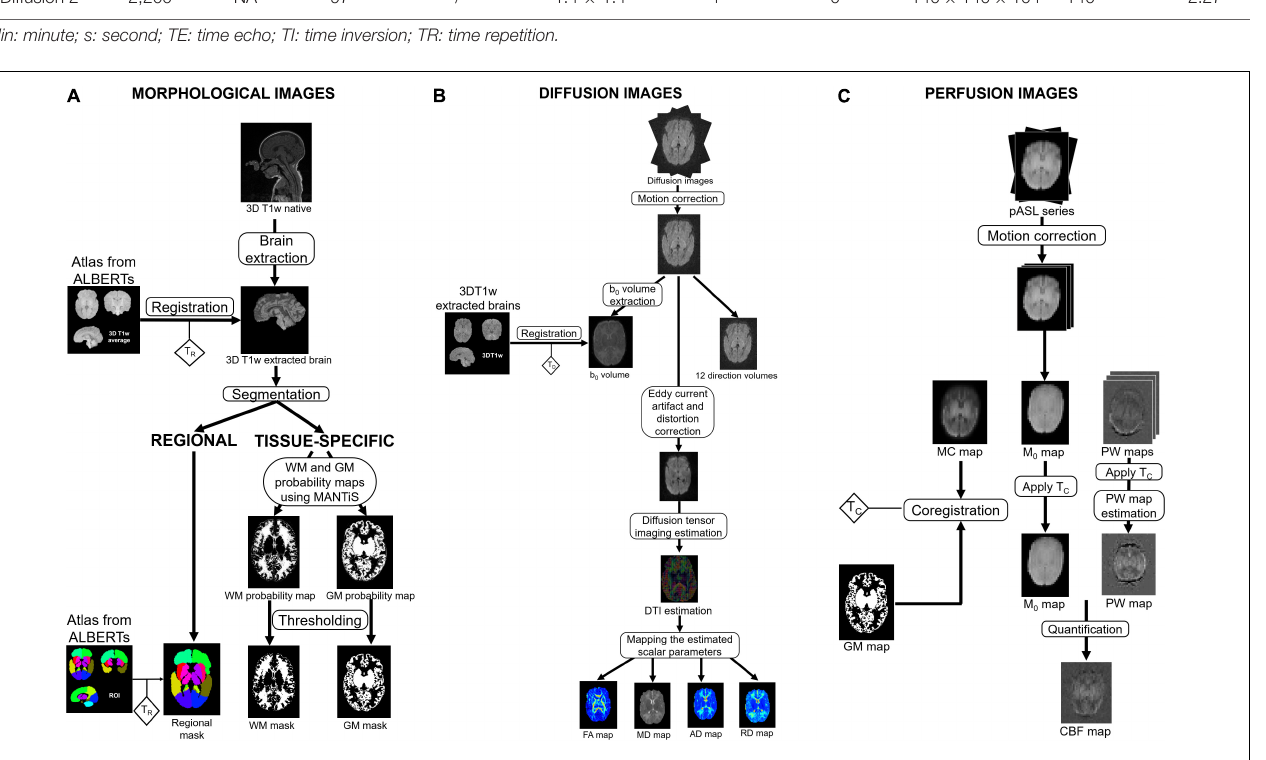
FIGURE 1 | Overview of the processing pipeline for one subject, illustrating the process of morphological (A) , diffusion (B), and perfusion (C) imaging. The transformations T R , T C , and T D resulting from the different registration steps are represented by diamonds. AD: axial diffusivity, ASL: arterial spin labeling, CBF: cerebral blood flow, FA: fractional anisotropy, GM: gray matter, MC: motion corrected, MD: mean diffusivity, PW: perfusion weighted, RD: radial diffusivity, WM: white